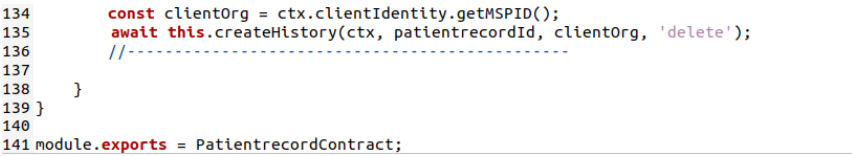
Figure 16. Smart-contract code using